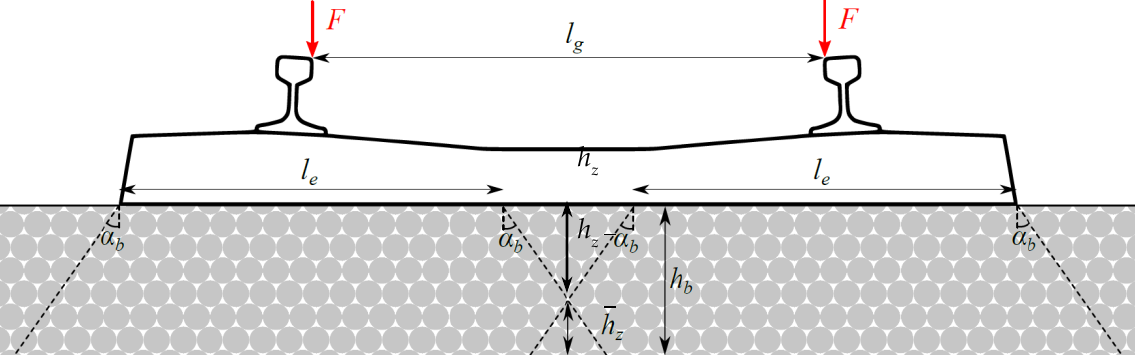
Figure 8. Superposition of the stress cones in the transversal direction.